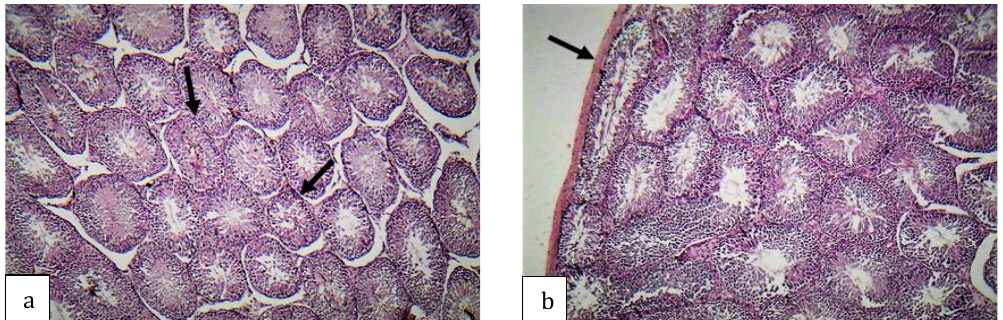
Figure2. A photomicrograph of the right testis of an adult male Wistar rat received H 2 O 2 (G1): showing a) dissolution of sperms (increased eosinophilia) atrophy and loss of spermatids (arrow), b) thick fibrous tunica albuginea (arrow) and disruption of seminiferous tubules (H&E, 40×)